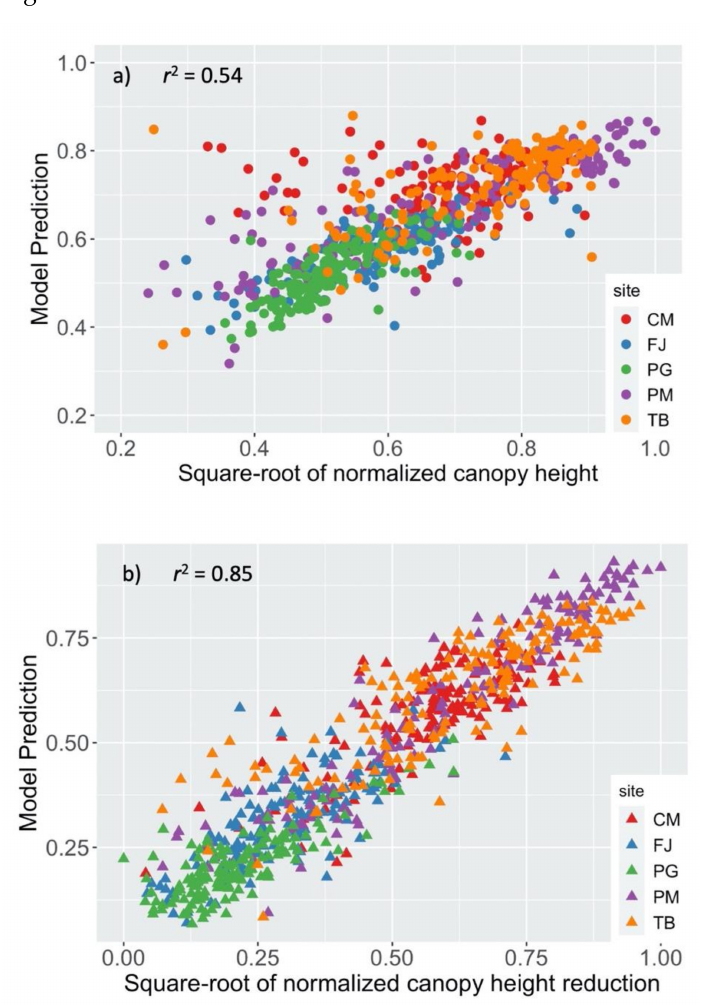
Figure 6. ( a ) Model-predicted versus LiDAR-derived pre-hurricane canopy height, and ( b ) model- predicted versus LiDAR-derived canopy height reduction. Codes for the five sites: CM—Caño Mart í